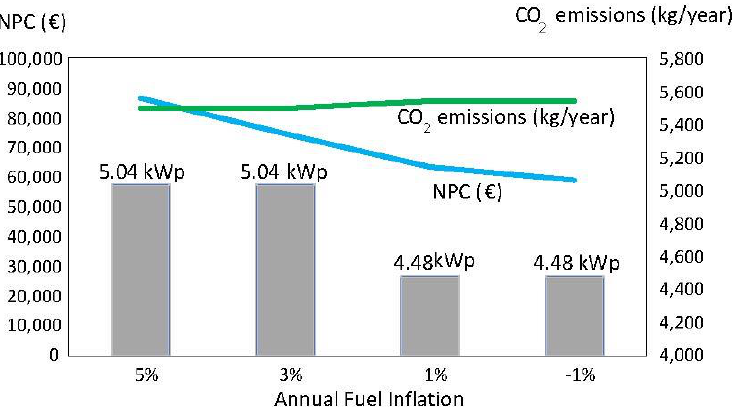
Figure 7. PV + Diesel systems. Optimal solutions include cases with a PV cost of 1 €/Wp.